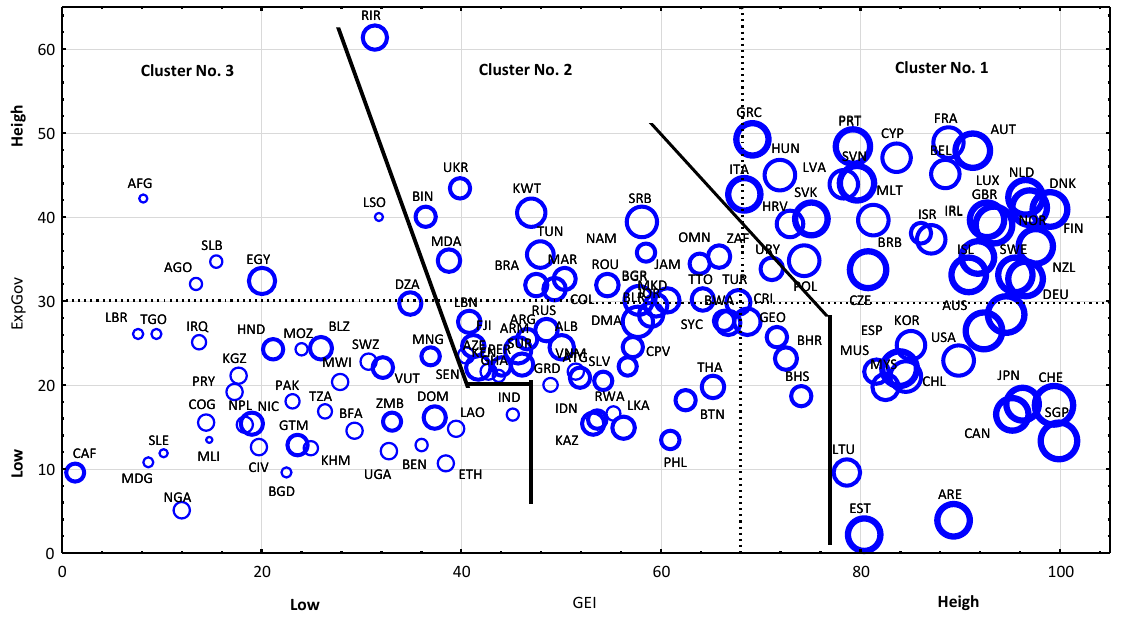
Figure 2. Ordination of the countries on the governance efficiency and the share of government expenditures in GDP (the larger diameter of the bubble illustrates the relatively better level of country environmental